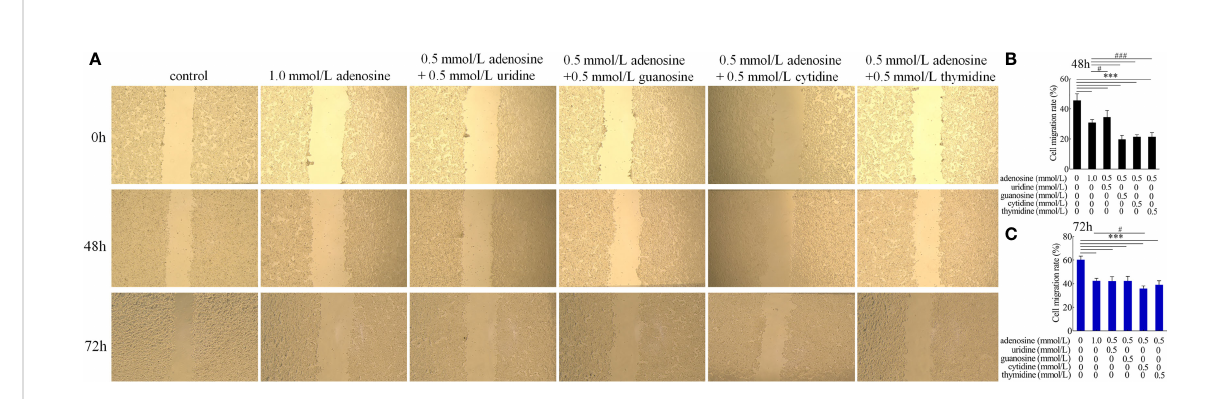
FIGURE 11 Effect of adenosine and other nucleosides on (A) cell migration and cell migration rate of (B) 48 and (C) 72 h in cocultured HT-29 cells + freshly extracted human leucocytes. Images were obtained by an OLYMPUS inverted microscope (×20). Values are presented as means ± SD (n = 3/ group). Analysis of variance with Tukey. compared with the control, ***P < 0.001; compared with to the adenosine group, # P < 0.05; ### P <